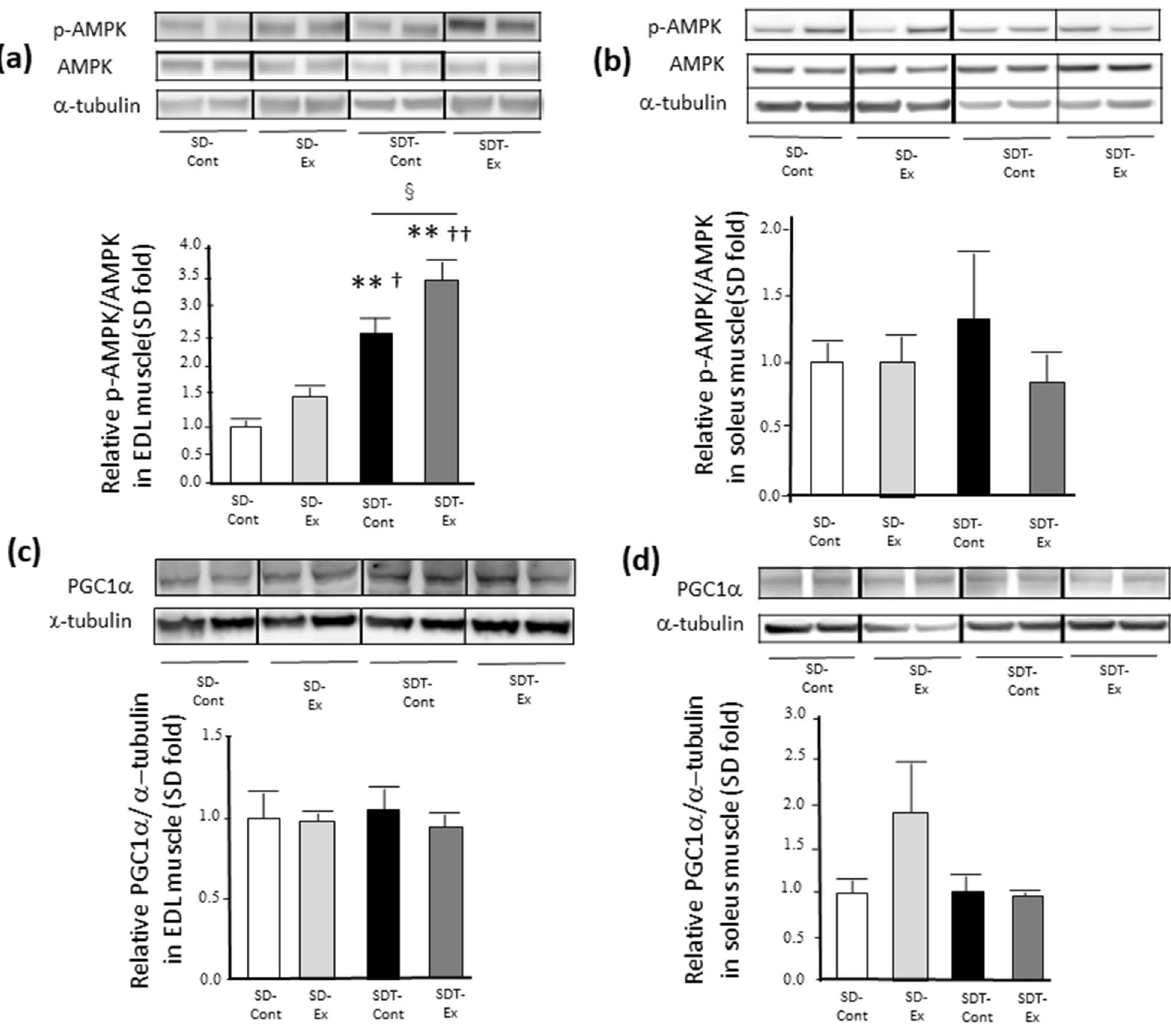
Fig. 6 Protein expression of phosphorylated AMP‑activated protein kinase (AMPK) and proliferator‑activated receptor gamma‑coactivator‑1 alpha (PGC‑1α) in the extensor digitorum longus (EDL) and soleus muscles. Phosphorylated AMPK (a: EDL, b: soleus) and PGC‑1α protein expression (c: EDL, d: soleus) in the EDL and soleus muscles as determined by western blot analysis. Entire images of western blotting are shown in online Additional file 1: Fig. S7 and S8. Values are presented as mean standard error of the mean. SD‑Cont group, n ± group, n 6; and SDT‑Ex group, n 6. ** P < 0.01 vs. the SD‑Cont group, † P < 0.05 and †† P < 0.01 vs. the SD‑Ex group, and § P < 0.05 vs. the SDT‑Cont = =